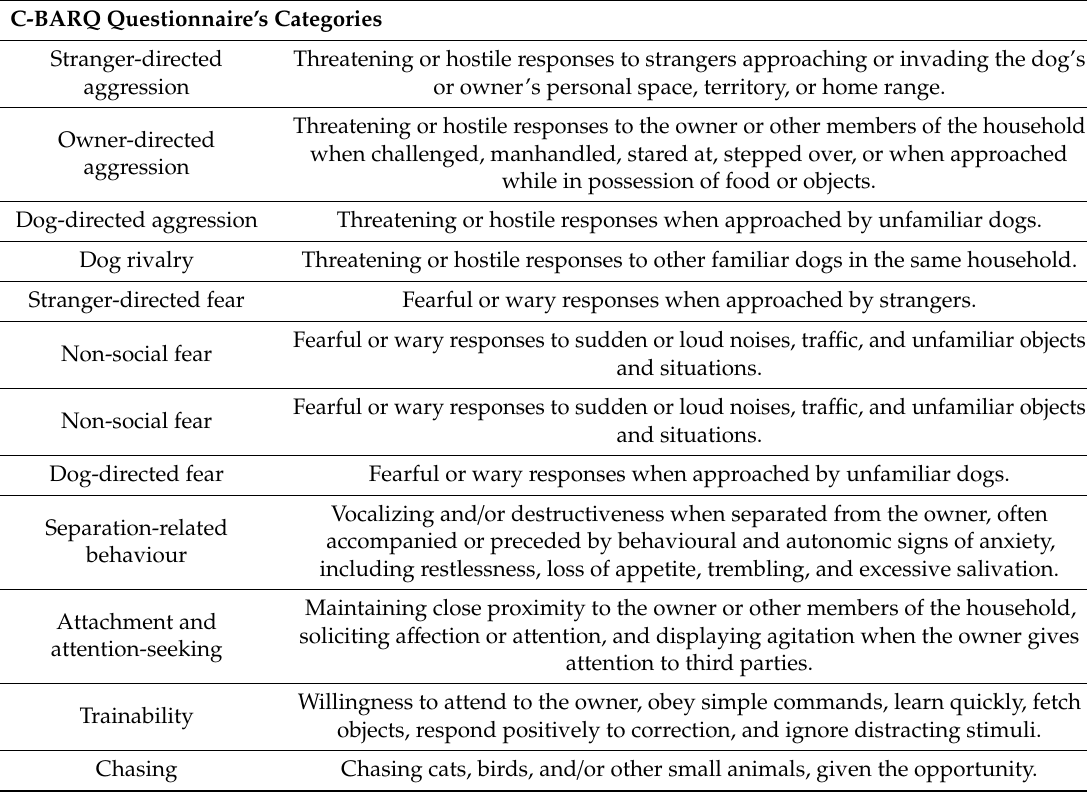
Table 2. The 14 di ff erent categories of dog behaviour included in the C-BARQ questionnaire. C-BARQ Questionnaire’s